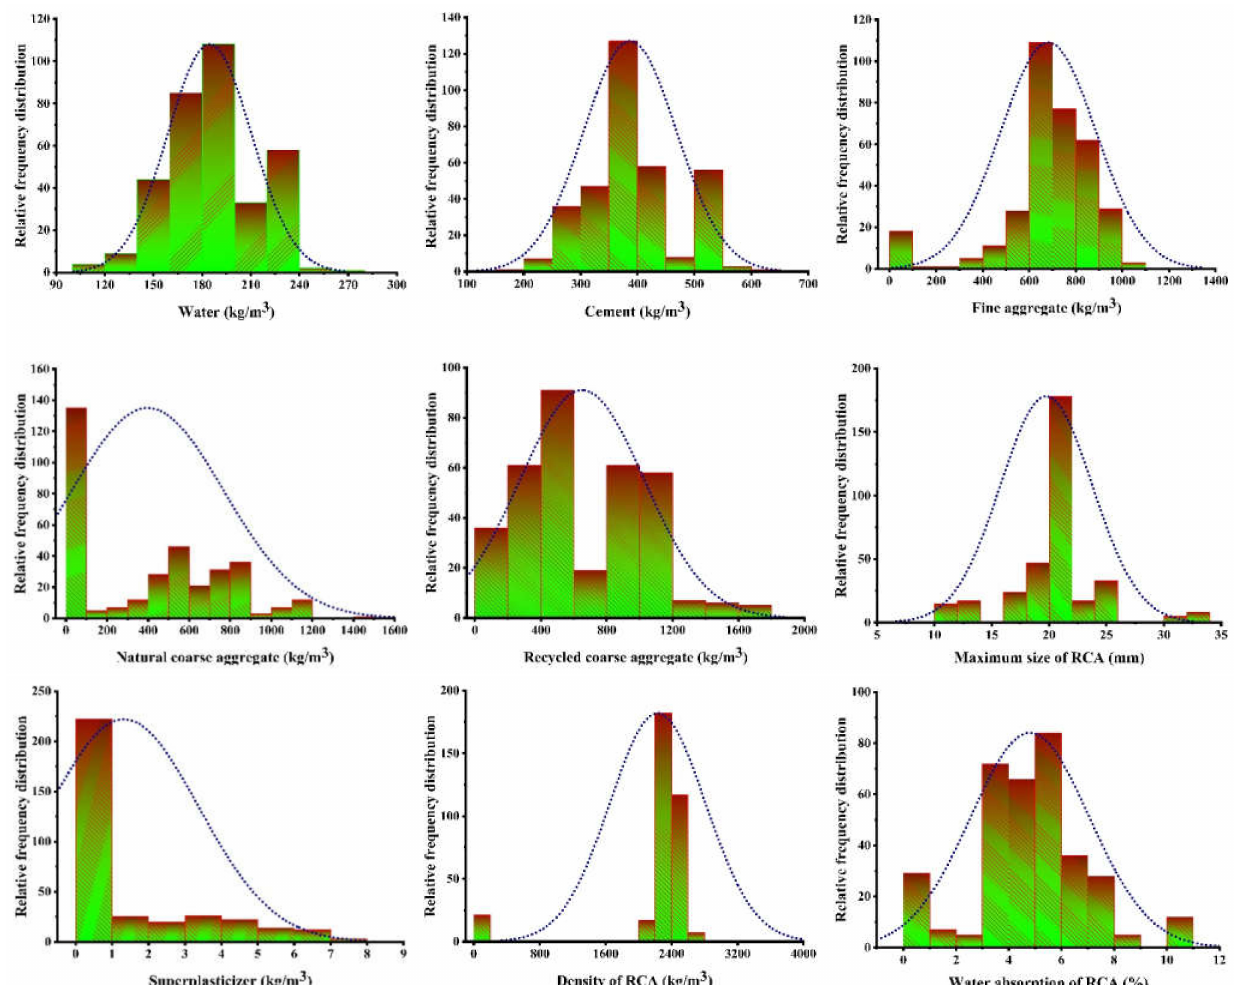
Figure 1. Histograms indicating the relative frequency distribution of the input